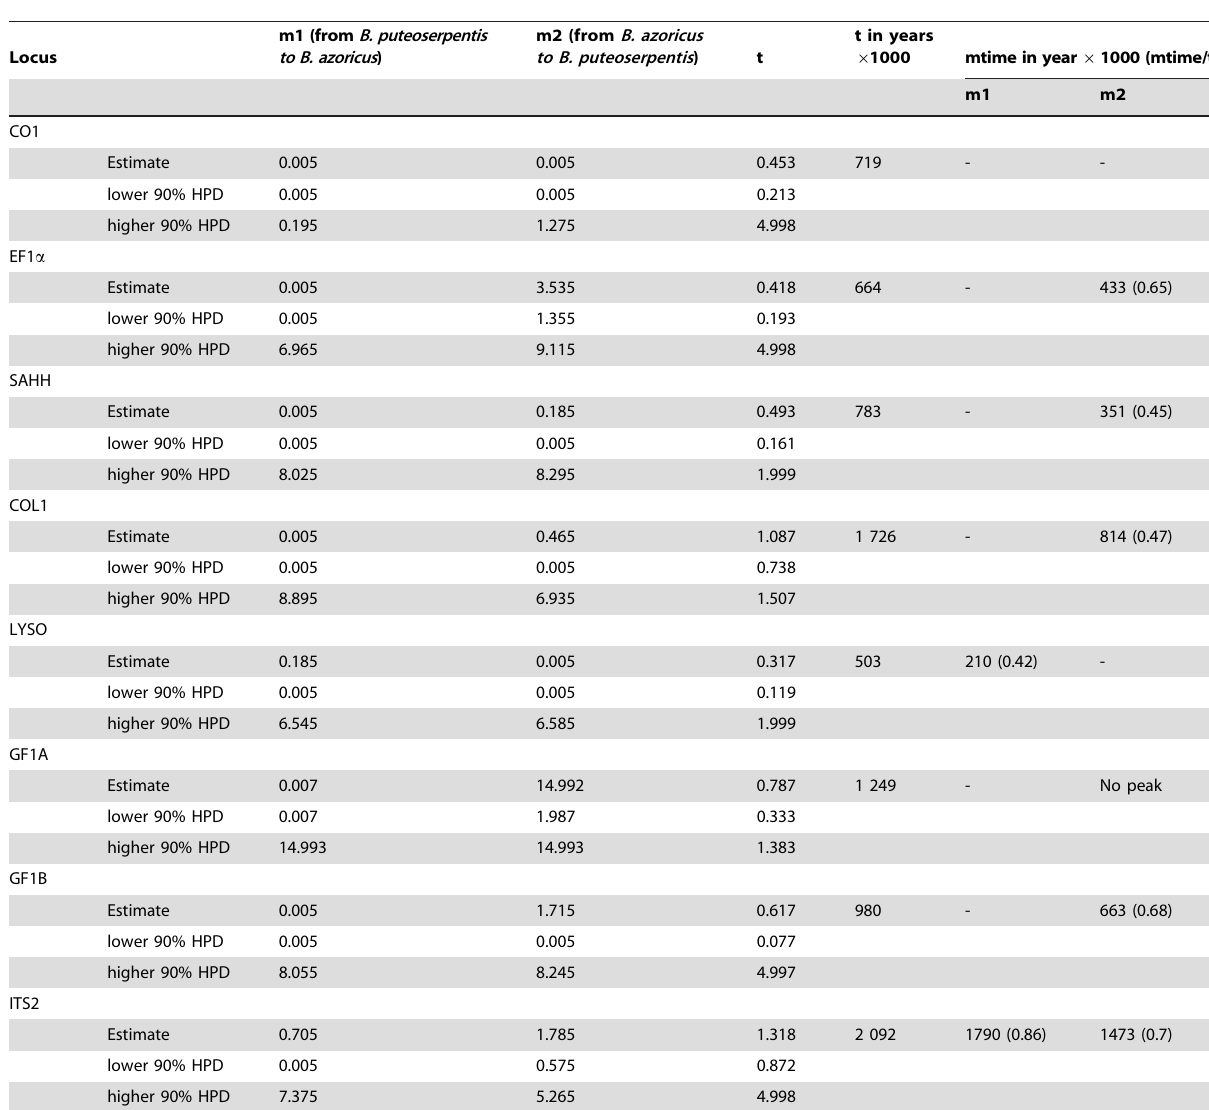
Table 5. Estimates and the 90% Highest Posterior Density (HPD) Intervals of Migration Rate Parameters, and maximum of the mean time of migration events ( mtime ), obtained from IMa analyses of the 8 loci. m1 (from B.puteoserpentis m2 (from B.azoricus toB.azoricus ) toB.puteoserpentis Locus